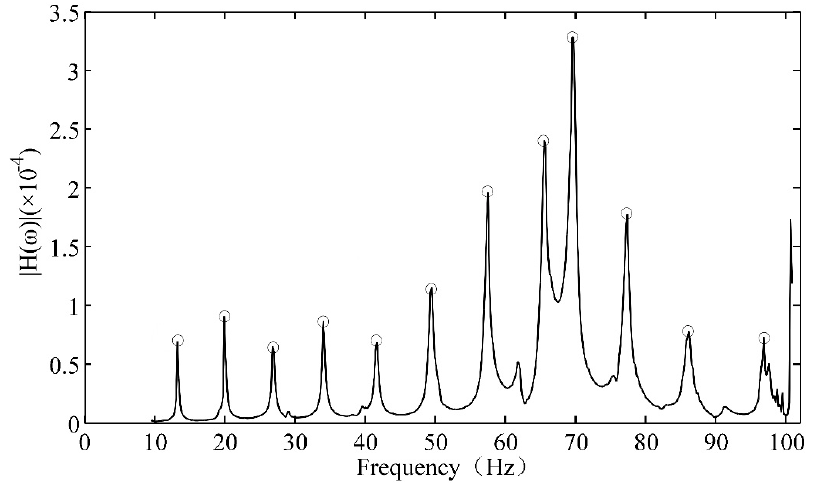
Figure 6. Frequency response function waveform of the intact wire.